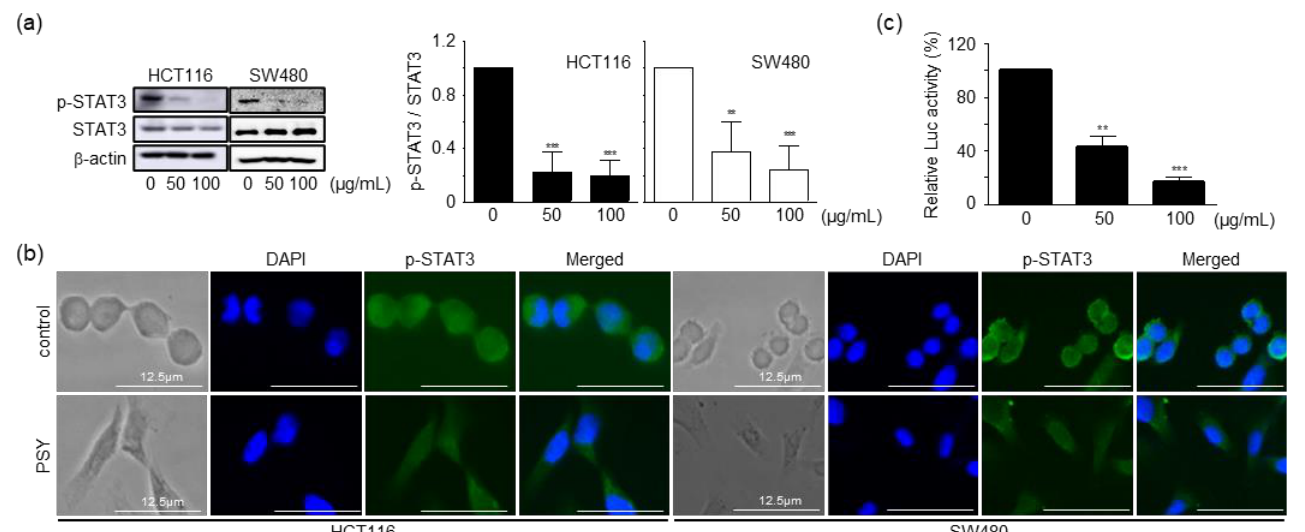
Figure 4. Effects of PSY on STAT3 in human CRC cells. ( a ) CRC cells were treated with PSY EtOH-Ex for 24 h, and cell lysates were subjected to Western blot analysis for STAT3 and p-STAT3. β -actin was used as an internal control. Data in the graphs represent the mean ± SD to that of the mock-treated cells taken as 1 (**, p < 0.01 and ***, p < 0.001 versus control). ( b ) Immunofluorescence staining of p-STAT3 and DAPI in the PSY (50 µg/mL)-treated CRC cells were analyzed by confocal microscopy. Scale bar, 12.5 μm. ( c ) HCT116 cells transfected with pSTAT3-Luc plasmid were treated with PSY for 24 h to analyze the transcriptional activity of STAT3. Data in the graphs are presented as the mean of fold-normalized luciferase (Luc) activities ± SEM to that of the untreated cells taken as 100% (**, p < 0.01 and ***, p < 0.001 versus control).